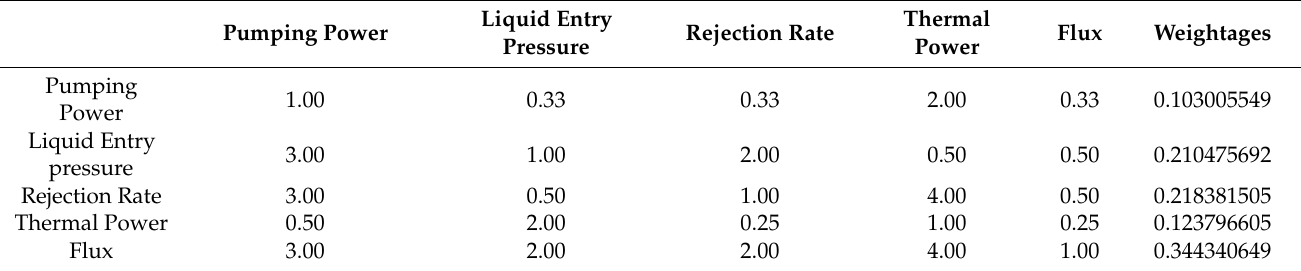
Table 3. Pairwise comparison of derivable outputs of MD using AHP-MDM by LDM2. Pumping Power